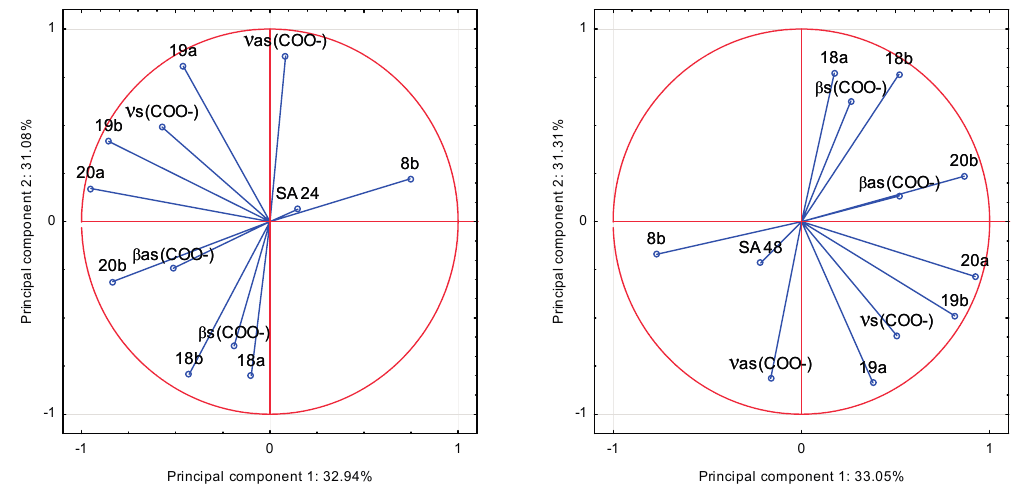
Figure 11. The values of the band wavenumbers in the FT–IR spectra of trans o -coumaric acid and alkali metal o -coumarates in relation to the degree of inhibition of growth in Staphylococcus aureus (SA) after 24 and 48 h of incubation in the two principal components